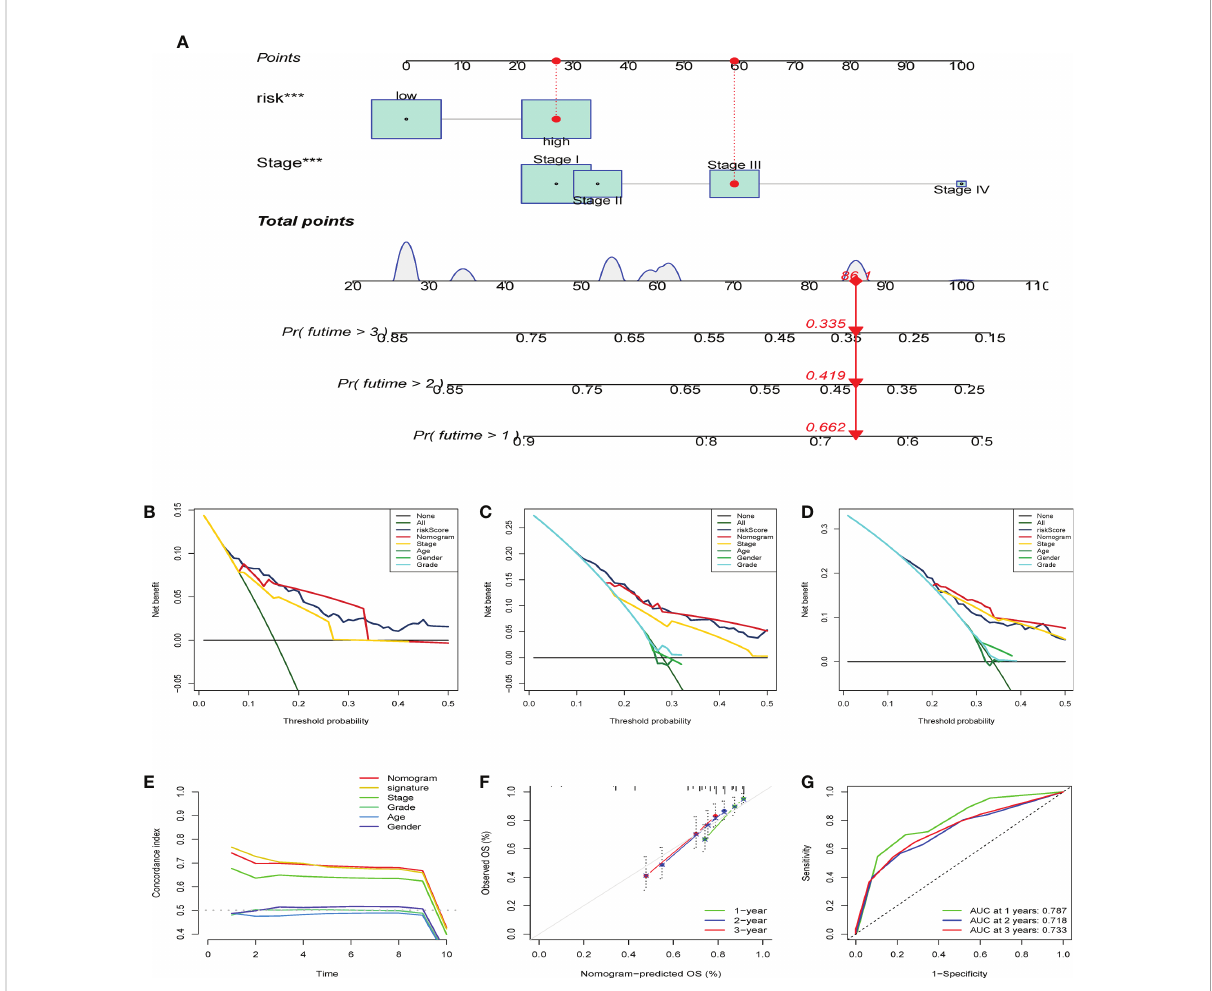
FIGURE 11 Establish of CS-dynamic nomogram and evaluate its clinical performance and bene fi ts of HBV-related HCC. (A) The dynamic nomogram integrates the variables (CS risk scores and stage) for predicting survival status at 1- year, 2-year, and 3-year. (B – D) DCA was employed to report the respective clinical net bene fi ts of CS dynamic nomogram at 1- year, 2-year, and 3-year. (E) C-index of the nomogram. (F) The CS dynamic nomogram calibration curves at 1, 2, and 3 years. (G) Time-dependent ROC curves estimate the nomogram ’ s forecasting value at 1, 2, and 3 years. ***p <